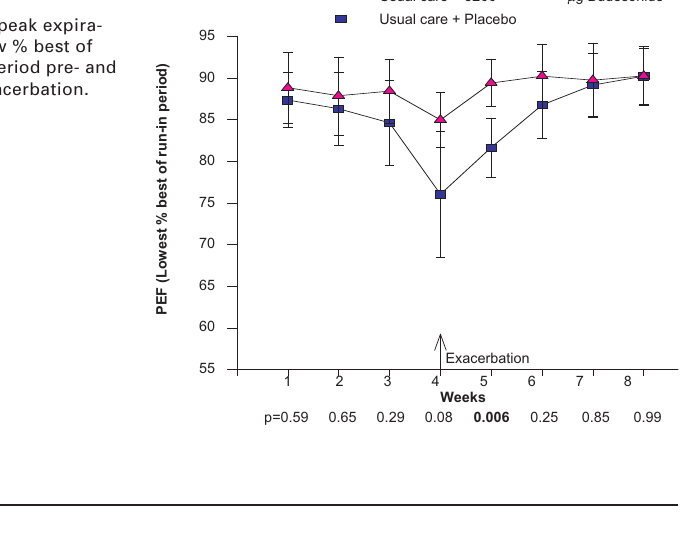
Figure 2 Symptom scores pre- and post exacerbation.